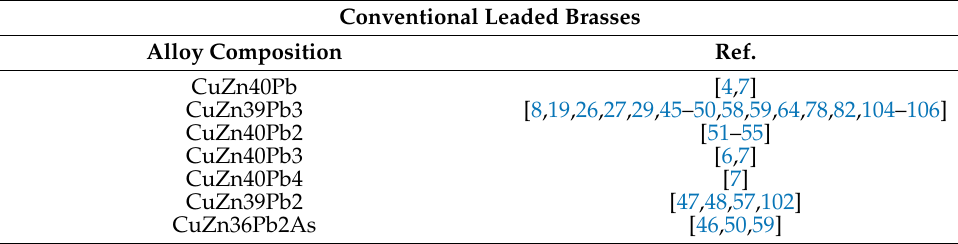
Table A1. Conventional leaded brass compositions.